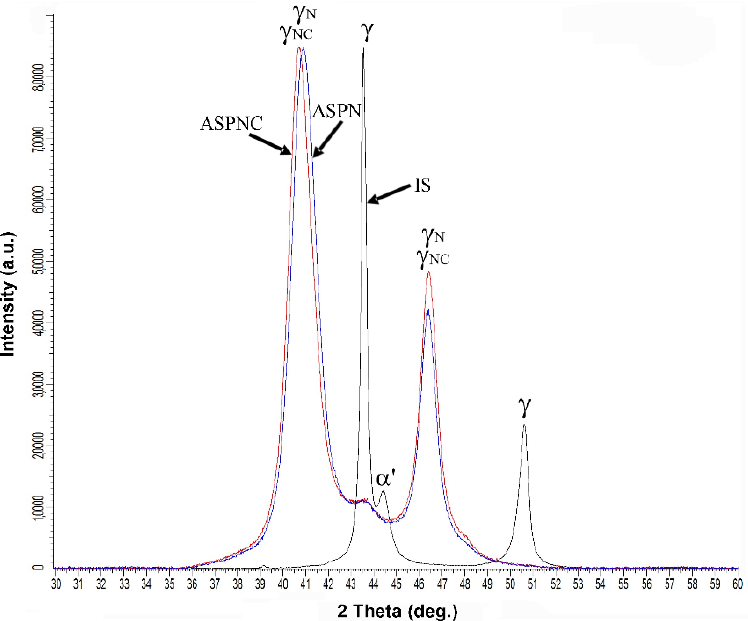
Figure 2. XRD patterns for AISI 316L austenitic steel in its initial state (IS) and after ASPN and ASPNC; γ—austenite, γ N —nitrogen S-phase, γ NC —nitro-carbon S-phase, α’—deformation martensite.